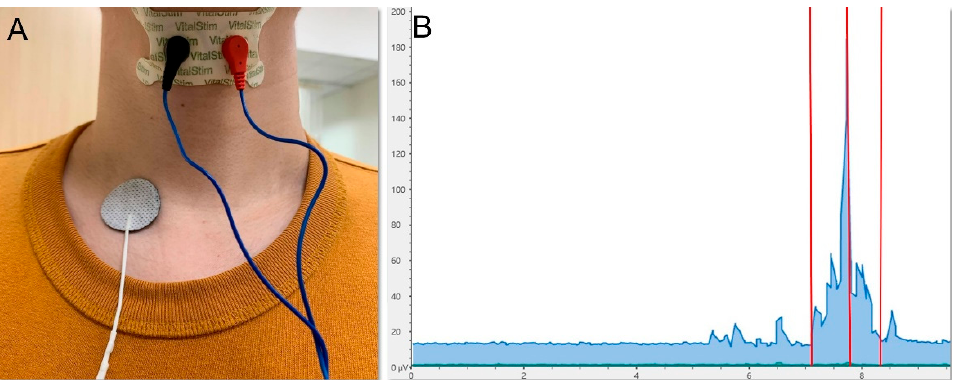
Figure 5. Electrode placement ( A ) and signal display ( B ) for the electromyographic assessment of swallowing muscle activity. Left red vertical line, onset of swallowing; middle red vertical line, peak amplitude; right red vertical line, end of swallowing.